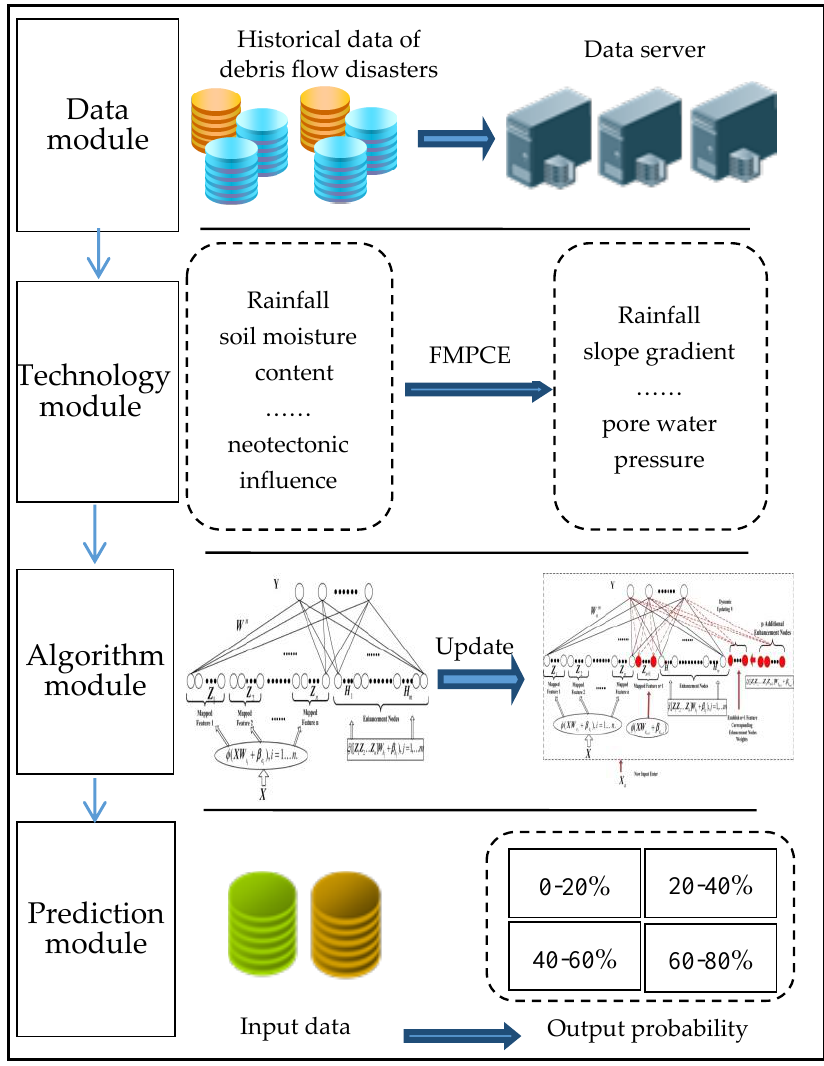
Figure 5. Debris flow prediction model.